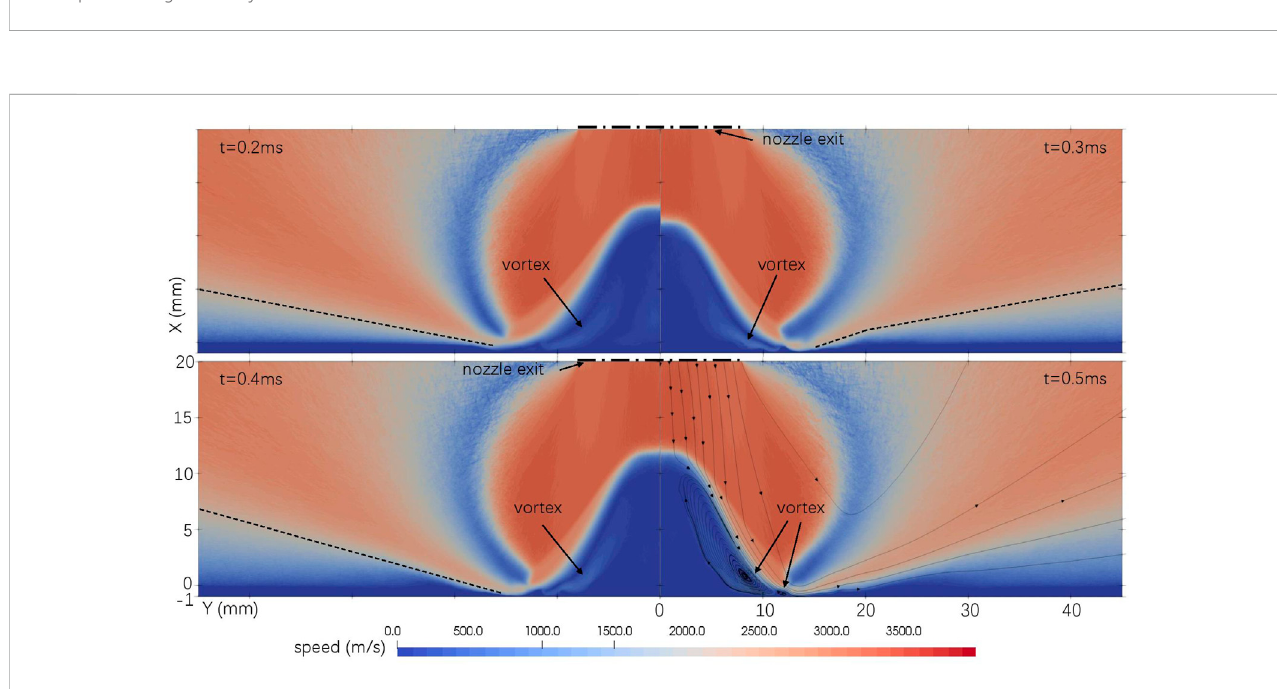
Comparison of gas pressure fi eld between the stochastic collision model and MPPIC at t = 0.375